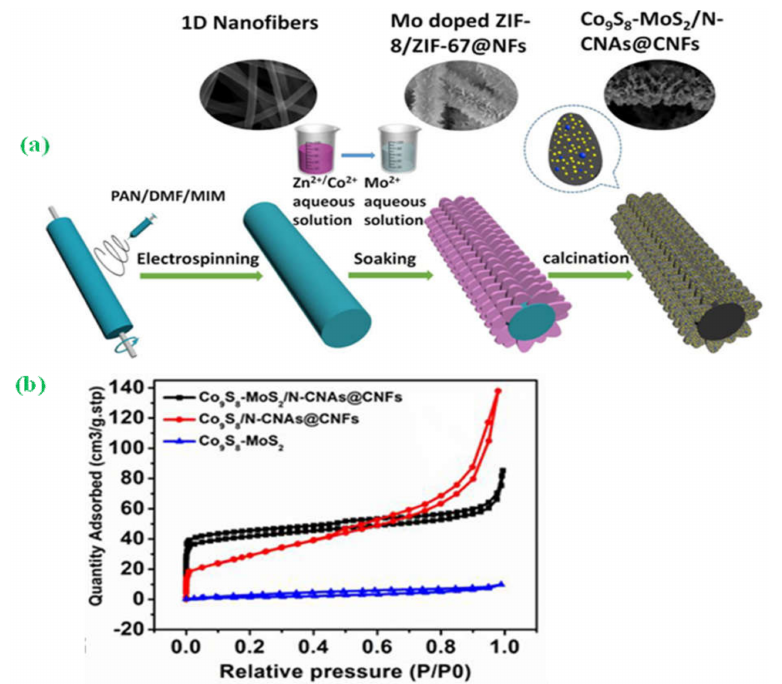
Figure 1. ( a ) Schematic illustration of the synthesis scheme of Co 9 S 8 -MoS 2 /NCNAs@CNFs and ( b ) N 2 adsorption/desorption isotherms of samples. Copyright 2020 by the American Chemical Society [31].